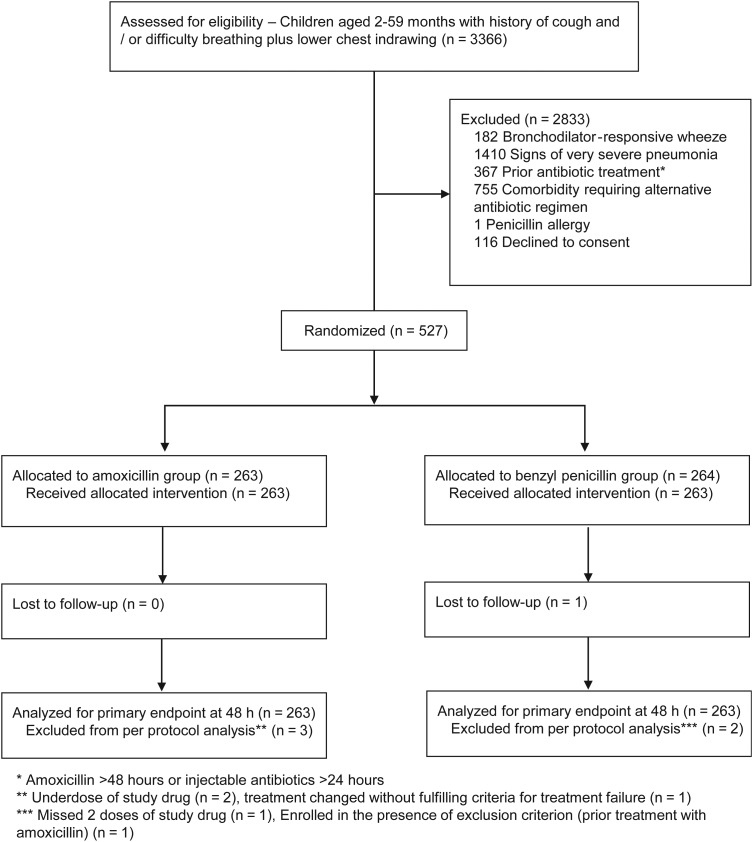
Screening allocation and follow-up of study participants.